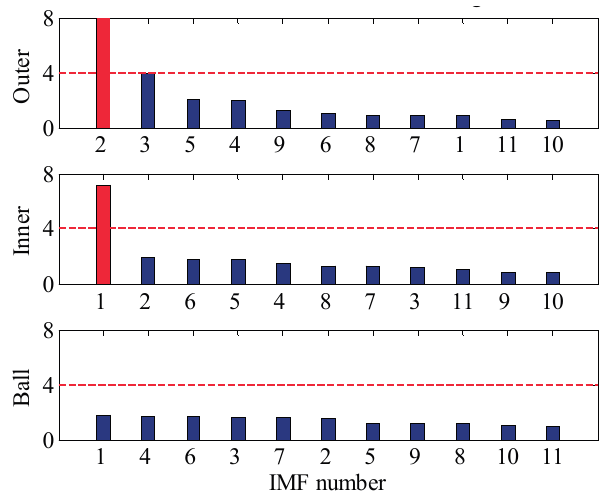
Figure13. FSM of simulated multi-fault signal.